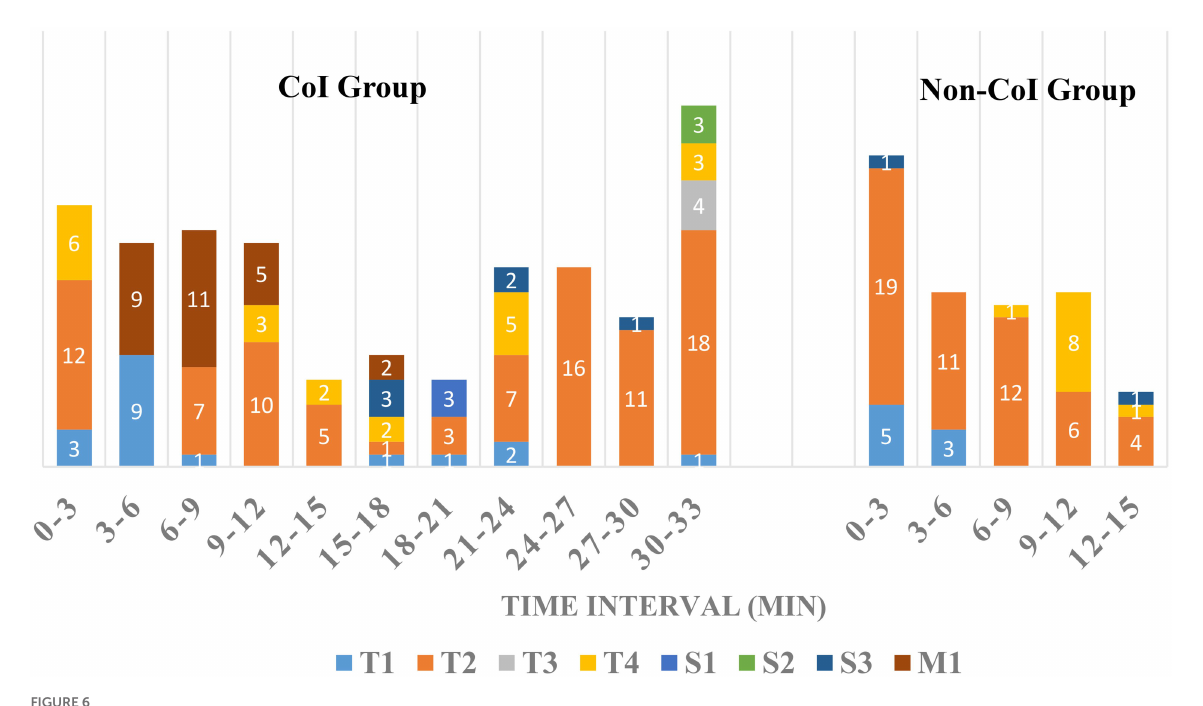
FIGURE 6 Student discourse STEM competencies in a CoI and Non-CoI group task. T1 = investigating and defining, T2 = generating and designing, T3 = producing and implementing, T4 = evaluating, S1 = science understanding, S2 = science social/ethical, S3 = science inquiry skills, M1 = mathematical